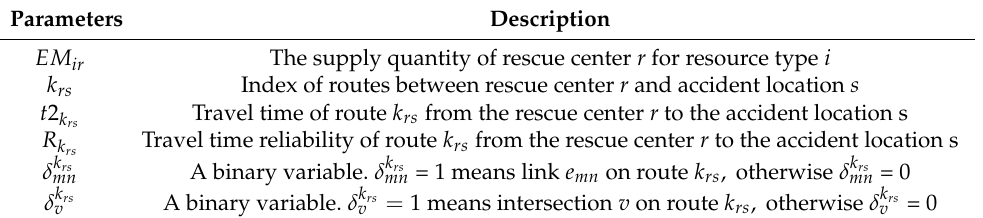
Table 3. Decision